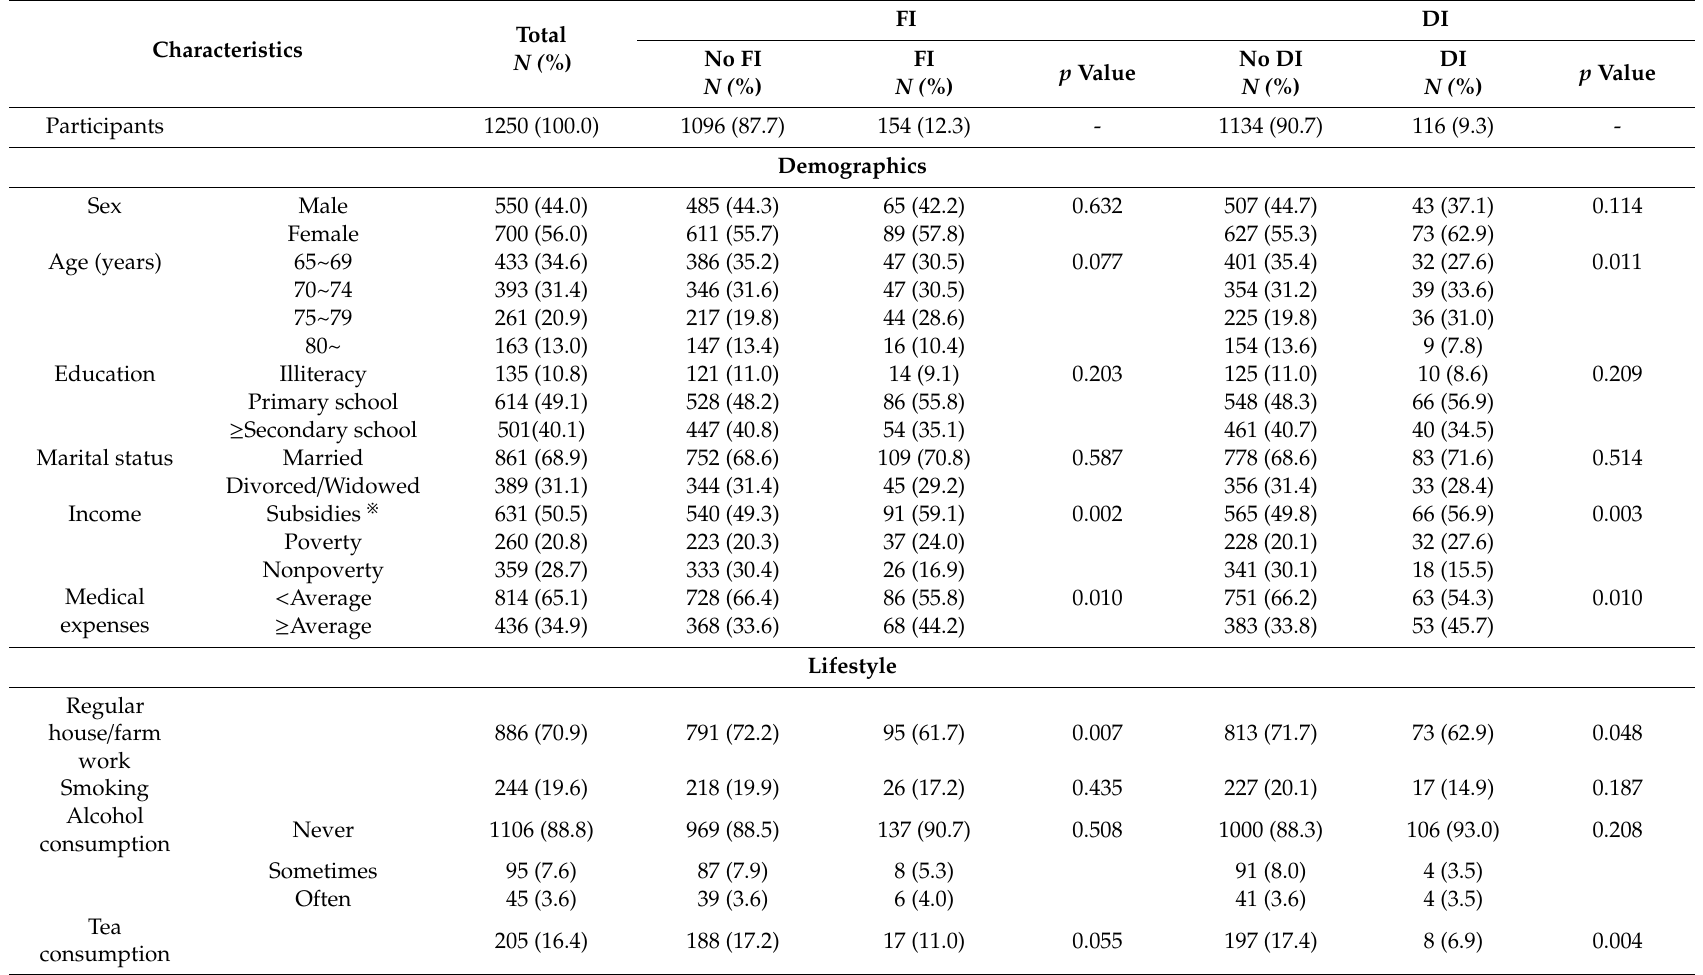
Table 1. Major characteristics of study population ( n =